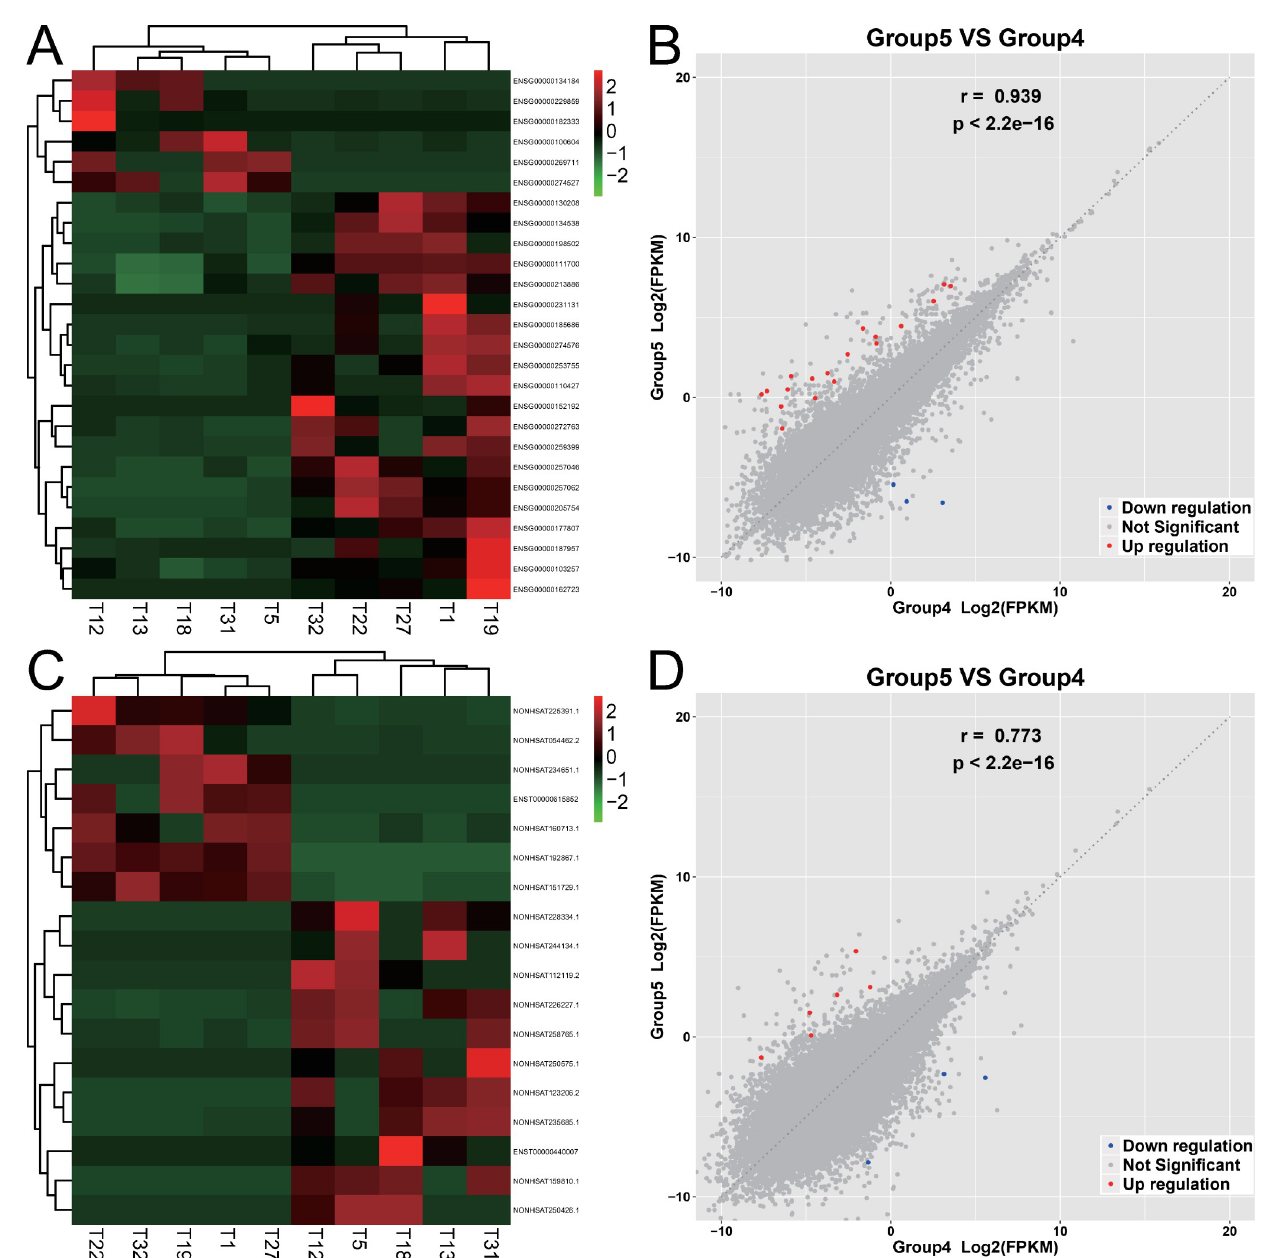
Fig 6. Expression differences of mRNAs and lncRNAs between early GBC and advanced GBC. Group 4 is early GBC including T5 T12 T13 T18 T31. Group 5 is advanced GBC including T1 T19 T22 T27 T32. (A) The heatmap figure of mRNA expression between the two groups. The deeper the red, the higher the expression, and the darker the green, the lower the expression. (B) The correlation scatter diagram of mRNA expression between the two groups, the red dots are the upregulated mRNAs of advanced GBC relative to early GBC, the blue dots are the downregulated mRNAs, and the gray dots indicate the differences are not significant. (C) The heatmap figure of lncRNA expression between the two groups. (D) The correlation scatter diagram of lncRNA expression between the two